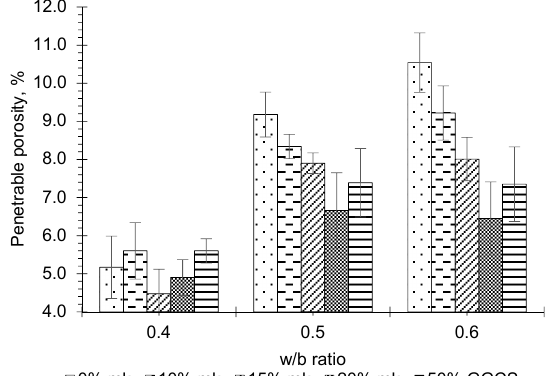
Figure 5. Water penetrable porosity of concrete at different w/b ratios.